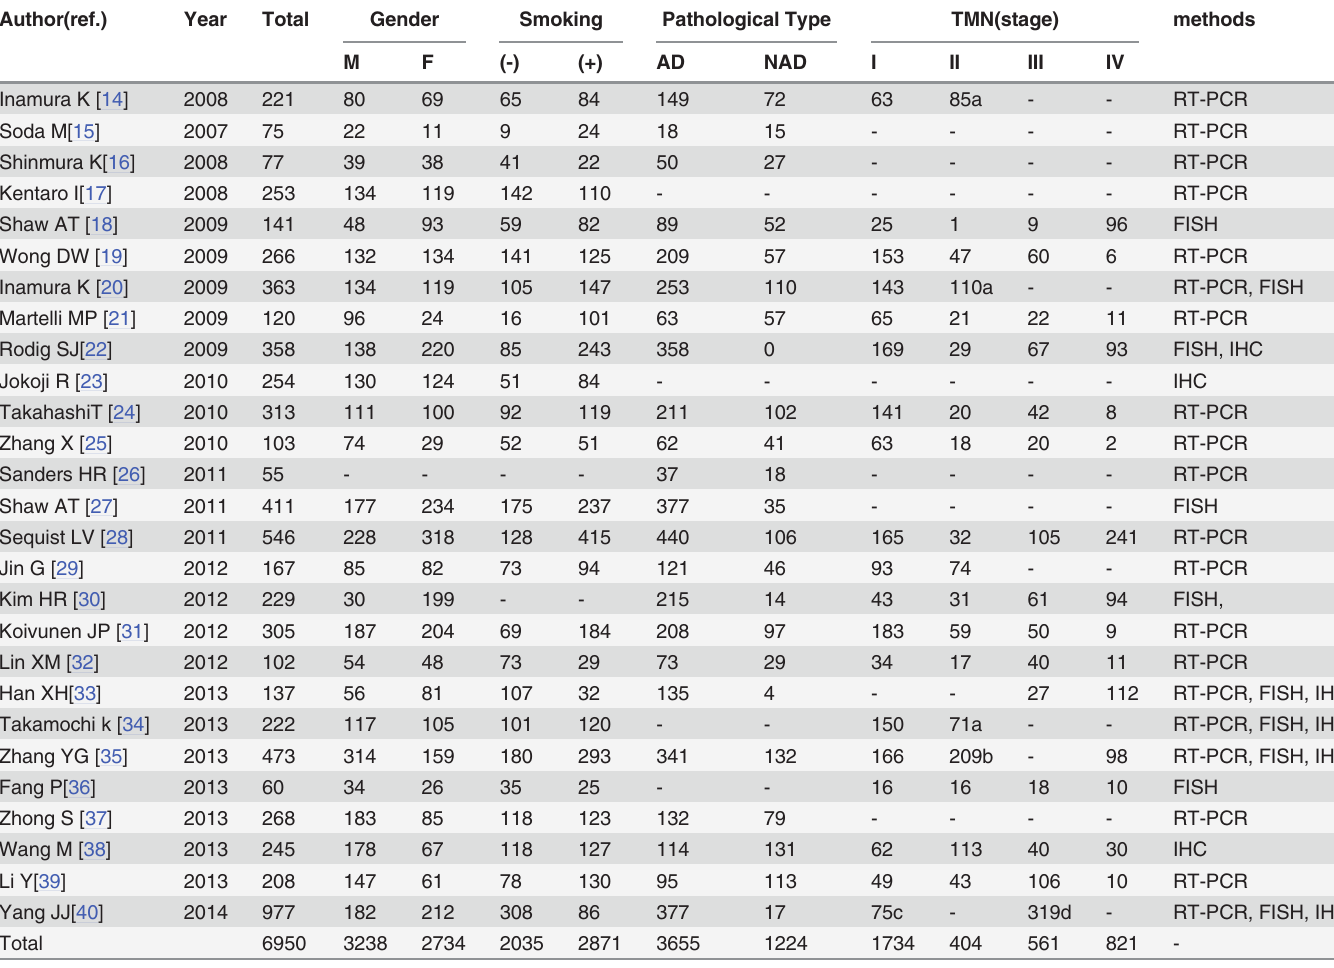
Table 1. Characteristics of included studies regarding patients and detected methods.